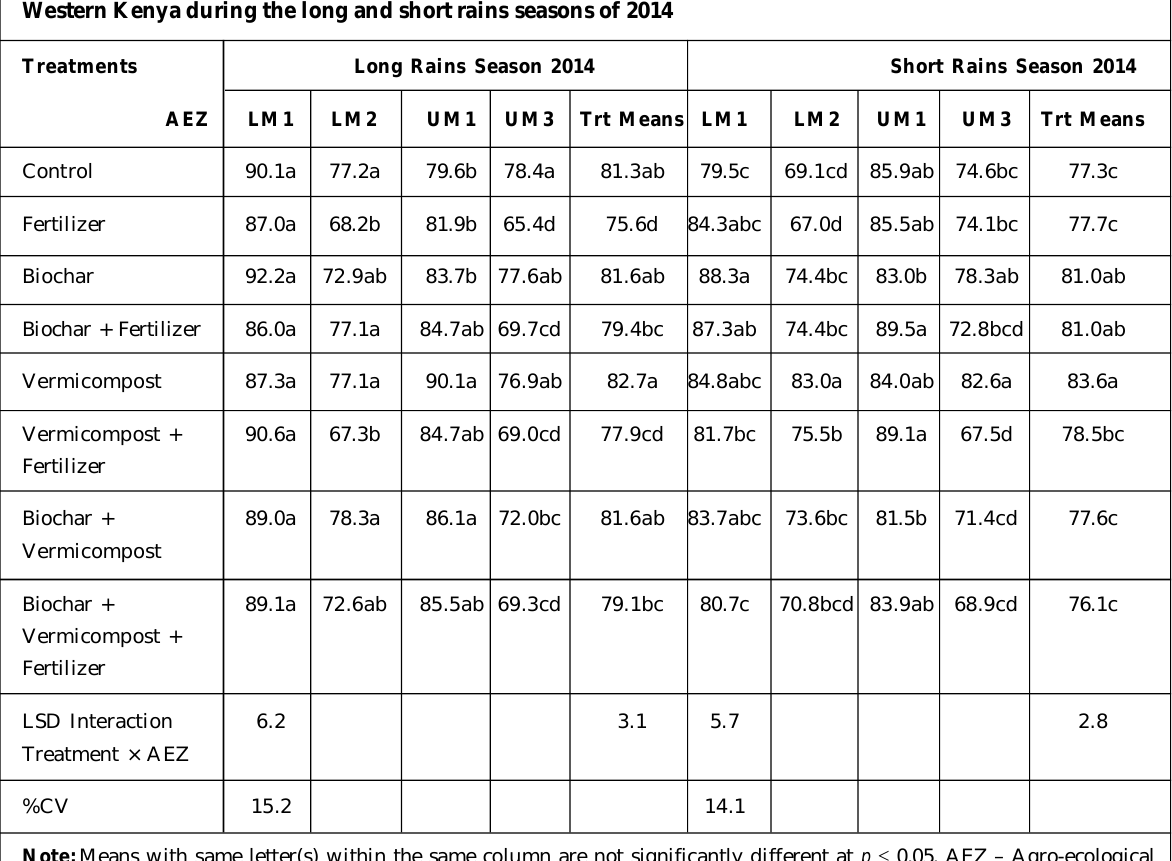
Table 4: Effect of different treatments on plant emergence (%) of common bean in different AEZ’s of Western Kenya during the long and short rains seasons of 2014